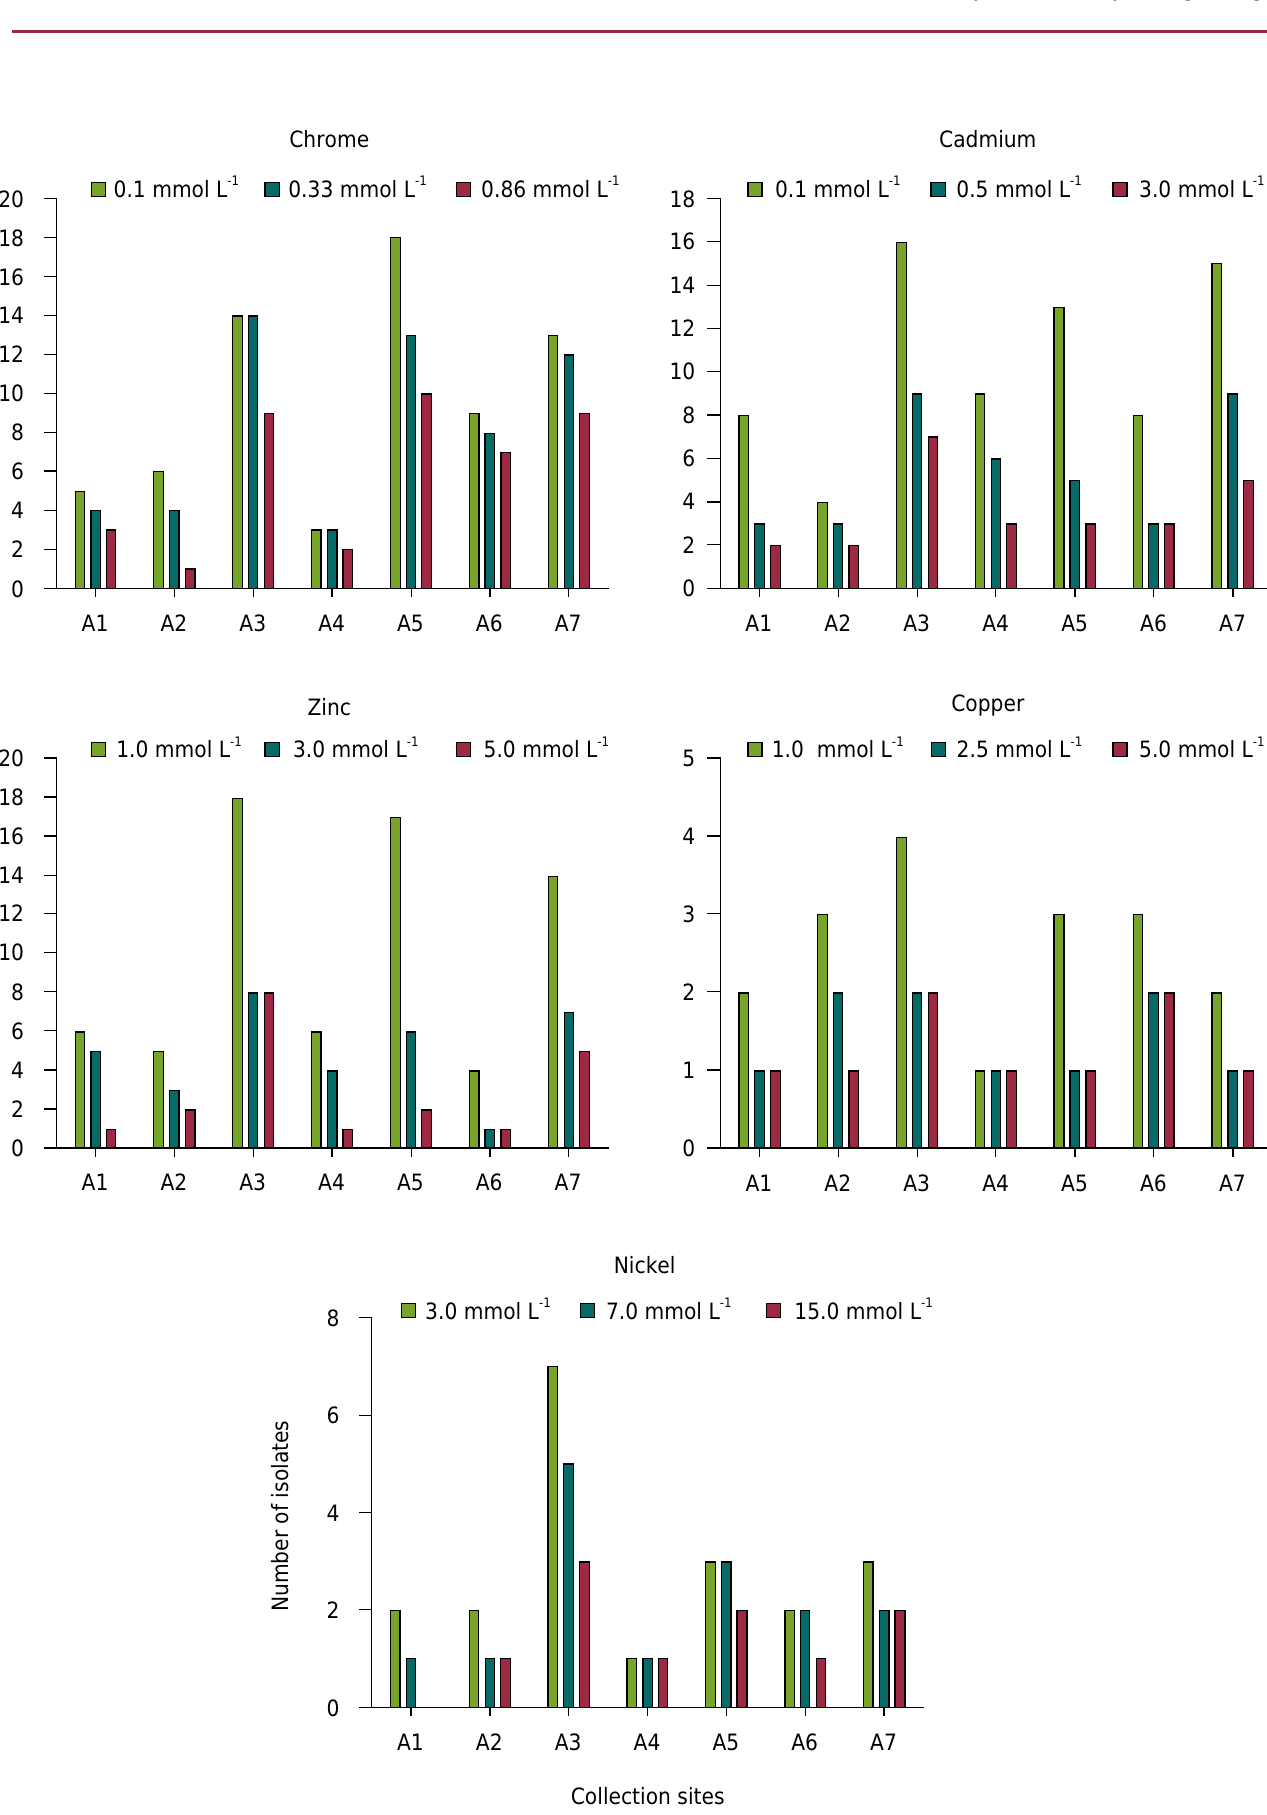
Figure 3. Number of heavy metal-resistant bacterial isolates at different Cr, Cd, Zn, Cu, and Ni concentrations in each representative